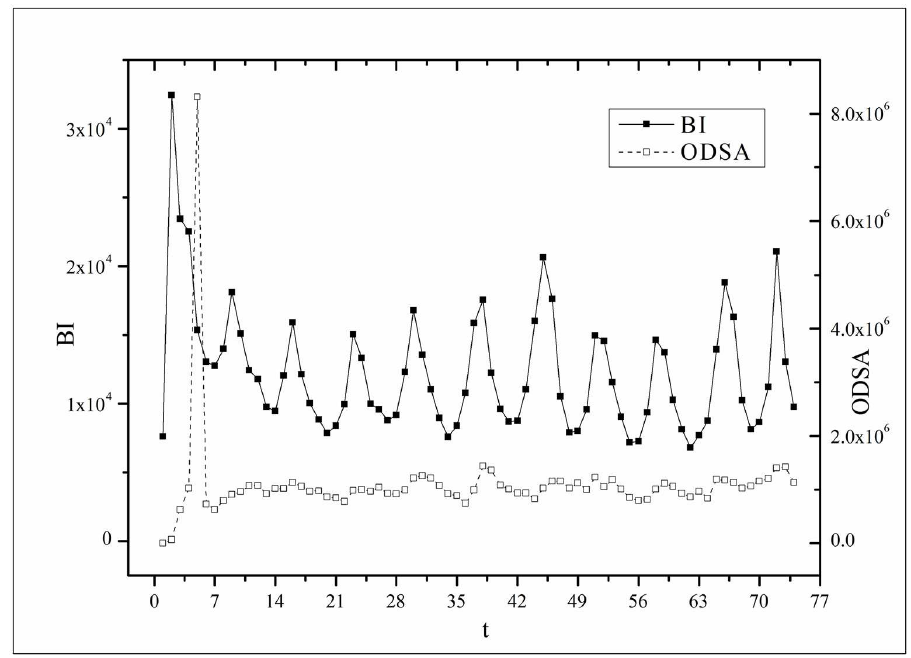
Fig 14. Correlation analysis of the Farmer dataset.